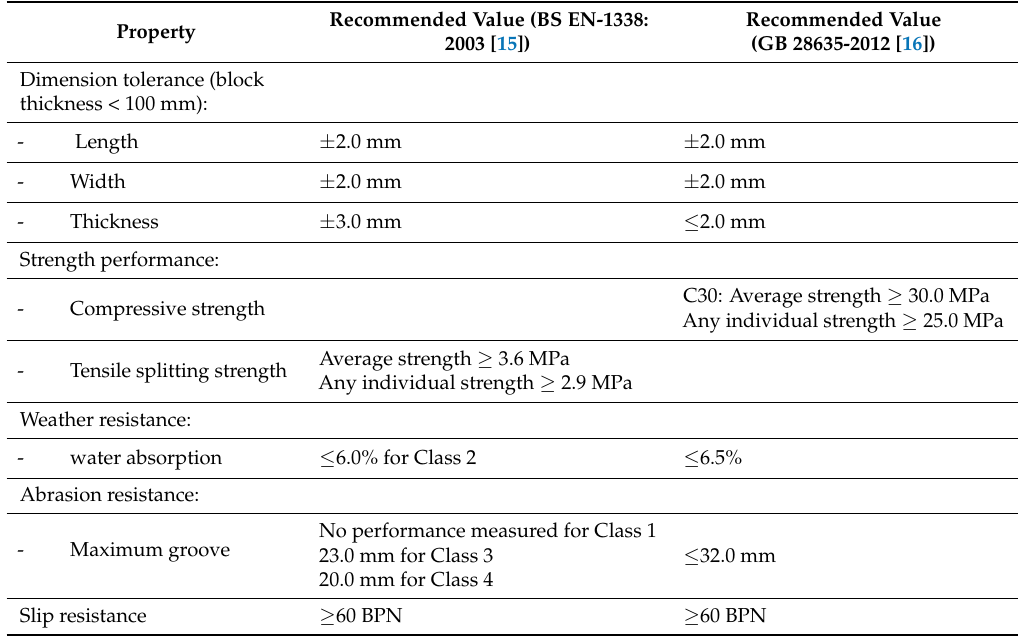
Table 1. Requirements of each property for different national codes.